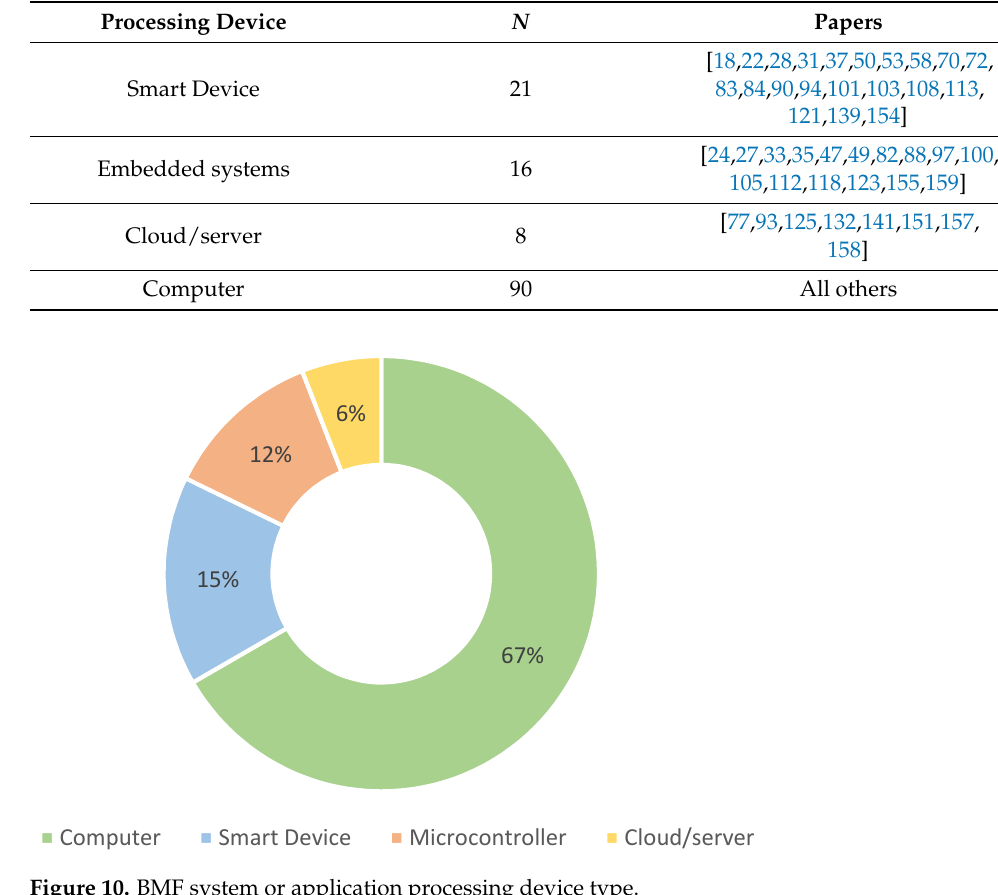
Figure 10. BMF system or application processing device type.